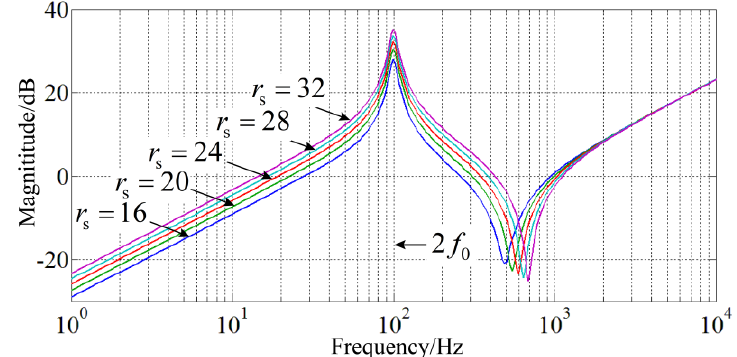
Figure 8. Magnitude plots of Z Lv_NICFPS (s) with different r s .